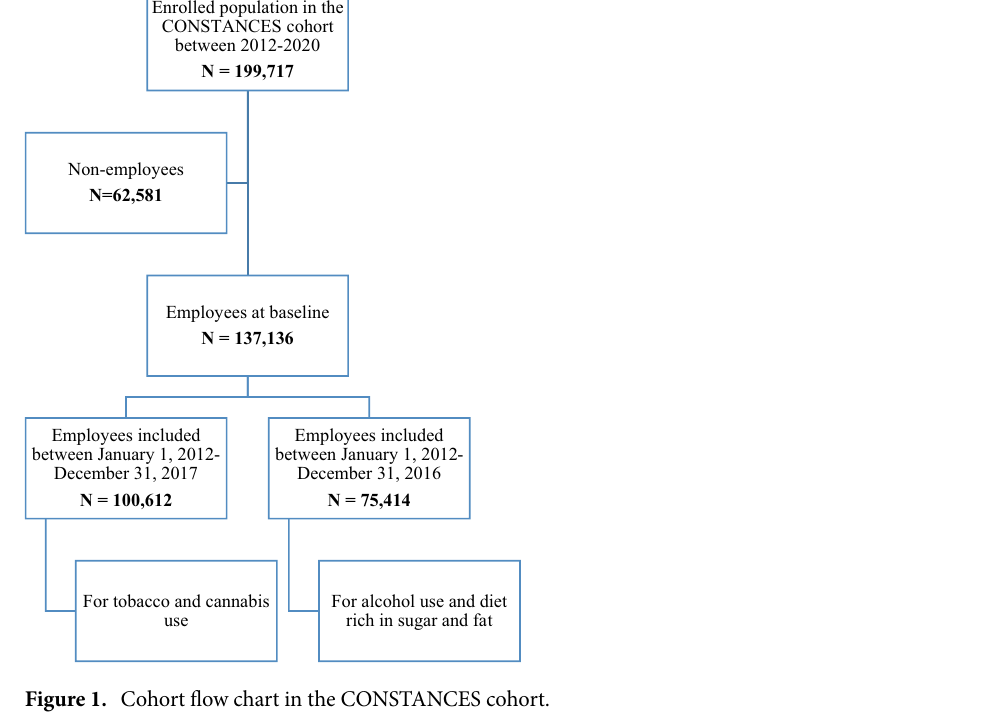
Figure 1. Cohort flow chart in the CONSTANCES